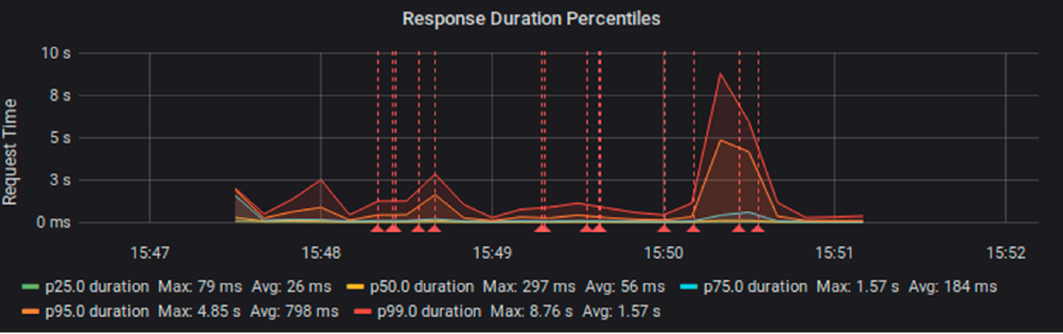
Figure 11. Trellis Cassandra performance degrades at 28 test workers.